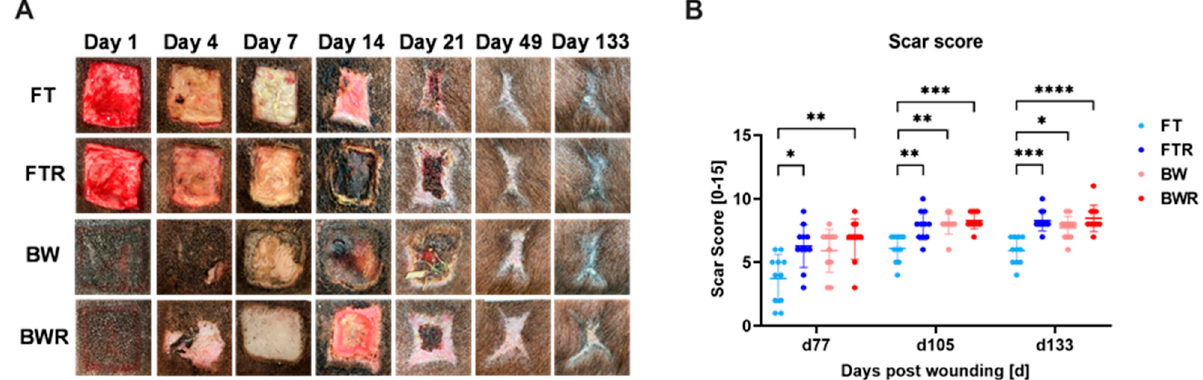
Figure 1. Burn injury and resiquimod ‐ induced inflammation in full ‐ thickness wounds lead to hypertrophic scarring. ( A ) Representative images of wound appearance during the study course. Wounds were regularly examined and photographed. A total of 44 wounds were created with eleven wounds per type. ( B ) The scar score of all wounds based on the modified Vancouver Scar Scale showed that resiquimod ‐ induced full ‐ thickness wounds and burn wounds had higher scores as early as day 77, whereas differences between non ‐ induced wounds were not apparent until day 105. Resiquimod ‐ induced wounds had higher scar scores than non ‐ induced wounds throughout the study course. Data are presented as mean ± SD. Statistical significance was determined using the Kruskal ‐ Wallis test and a Tukey post hoc test. * = p < 0.05, ** = p < 0.01, *** = p < 0.001, **** = p < 0.0001, FT = Full ‐ thickness wound, FTR = Full ‐ thickness wound with resiquimod, BW = Burn wound, BWR = Burn wound with resiquimod.